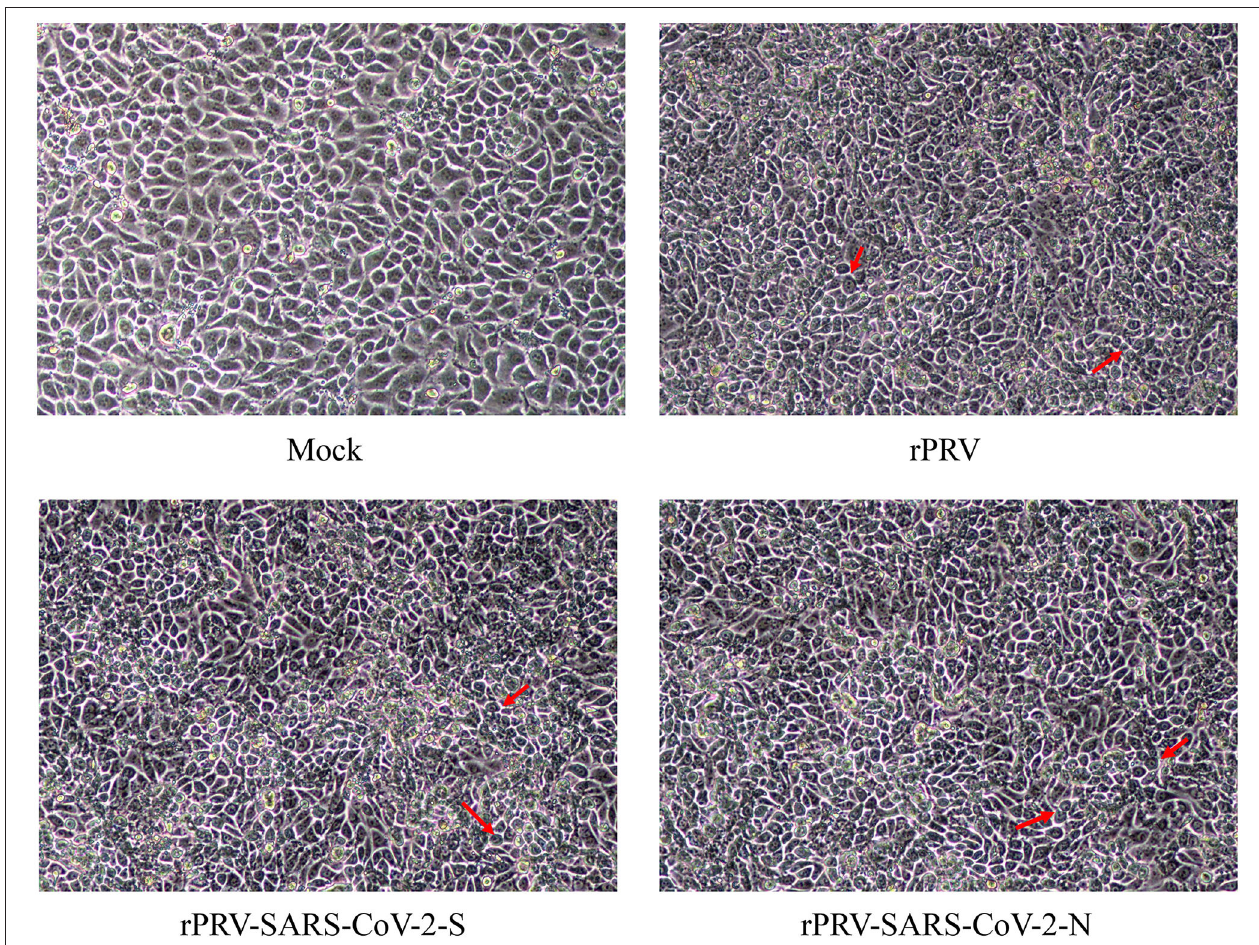
FIGURE 3 | Cytopathic of recombinant viruses in PK-15 cells. PK-15 cells were infected with each recombinant virus at MOI of 1. After 48h, cytopathic effects were observed. The cells indicated by the red arrow had CPE, which were rounder than the control